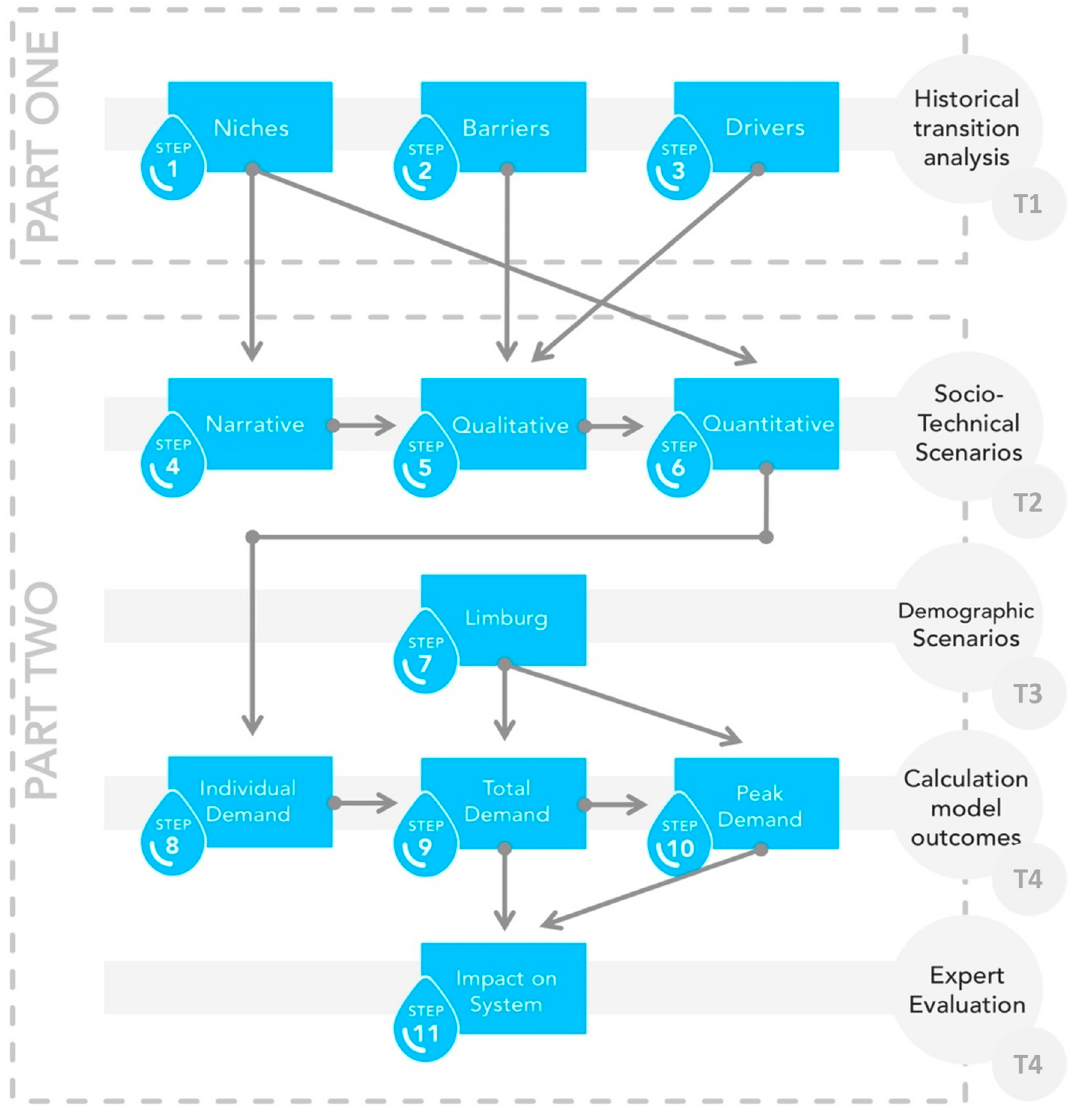
Figure 2. Conceptual framework.